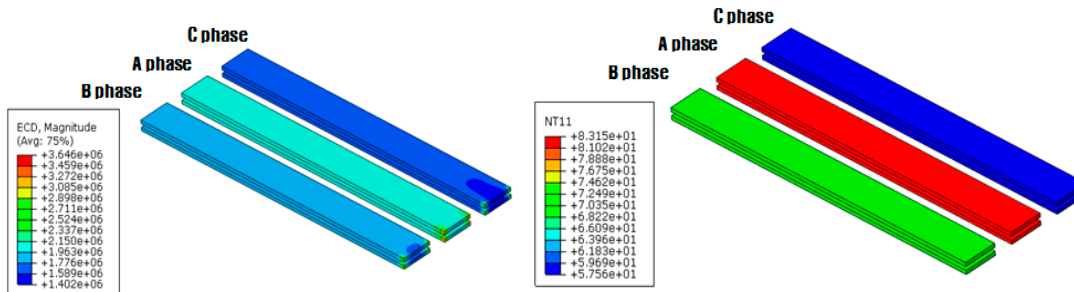
Figure 7. Electromagnetic and thermal analysis for 3-phase parallel array of plate-type bus-bar.